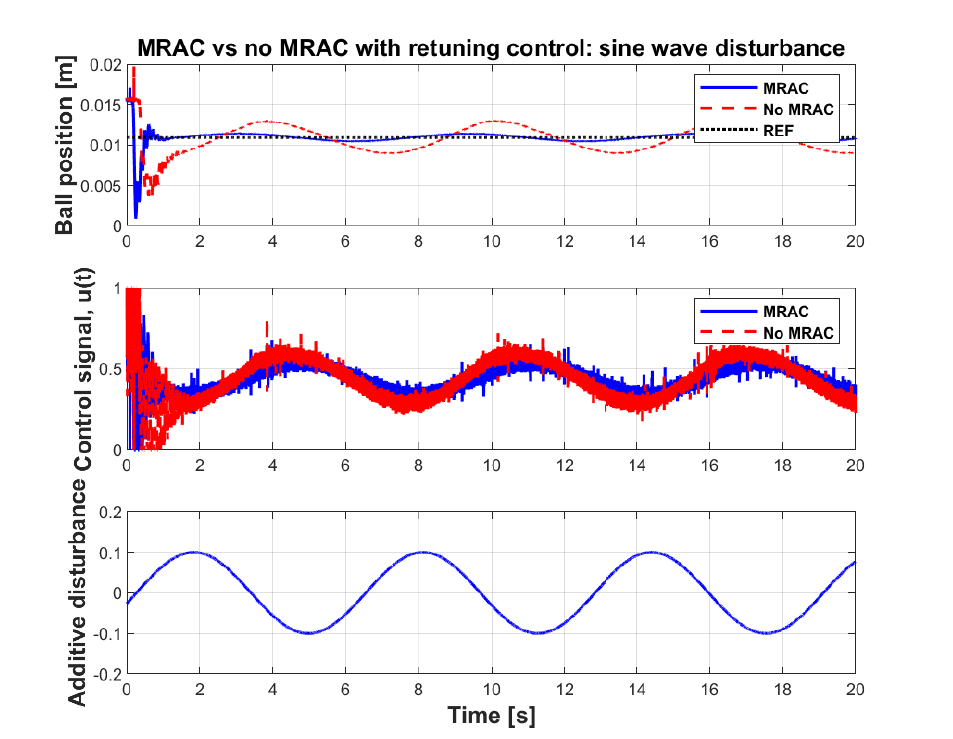
Figure 14. Sinusoidal disturbance responses of the multi-loop MRAC-FOPID control with NARX reference model and the FOPID control loop (When MRAC is disabled).